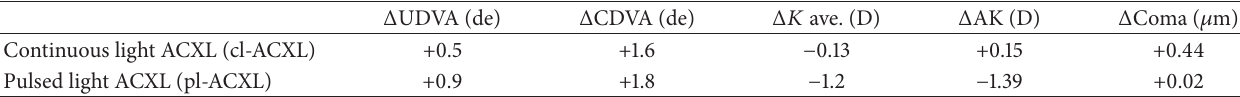
Table 1: Summary of the results.